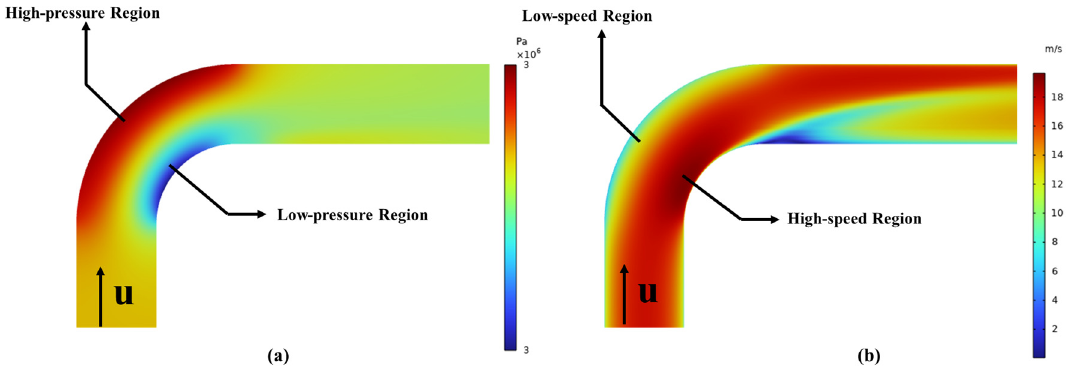
Figure 7. Equal cross-sectional distribution of pressure and flow velocity at the elbow: ( a ) Sectional view of pressure distribution; ( b ) Sectional view of velocity distribution.